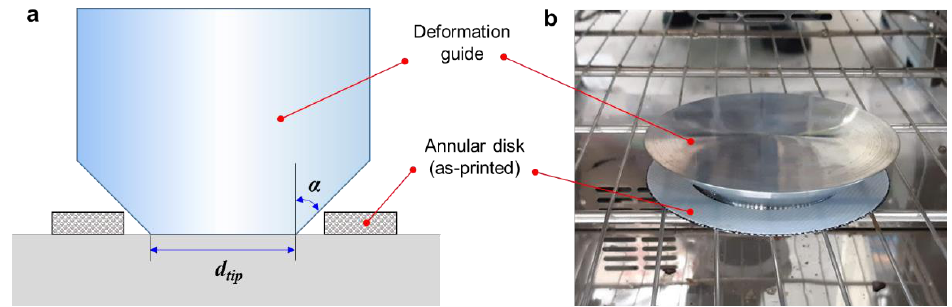
Figure 2. Constrained heat treatment using a tapered deformation guide: ( a ) schematic descrip- tion; ( b ) photograph inside the heating chamber. ( b ) photograph inside the heating